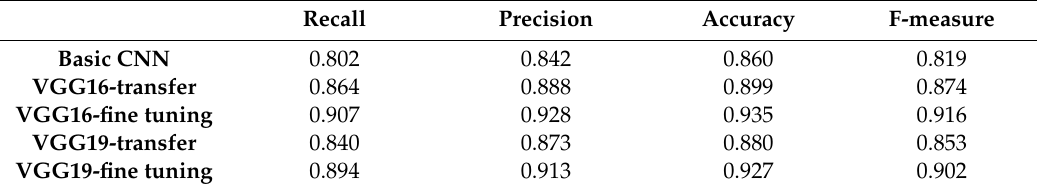
Table 2. Dental implant classification accuracy of CNN